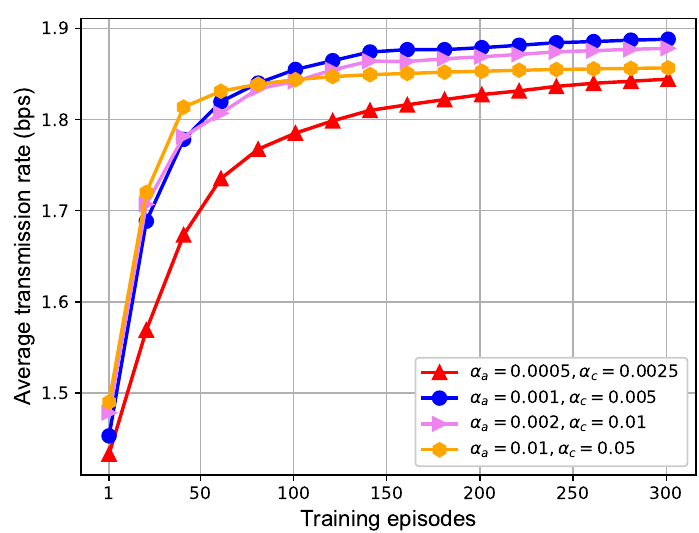
Figure 9. The convergence rate of the proposed actor-critic deep reinforcement learning according to different learning rate values.